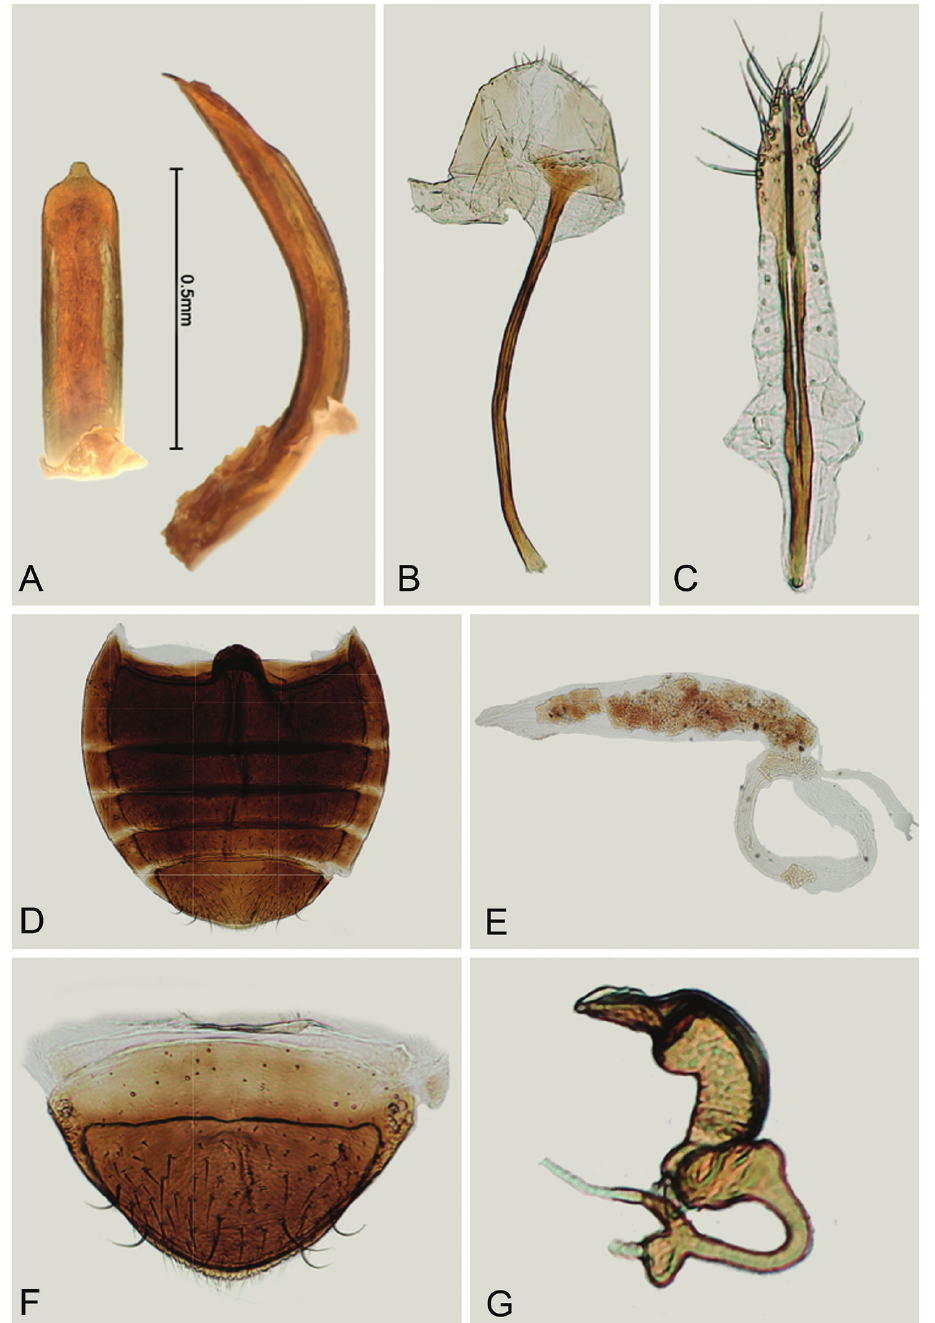
Figure 16. Andersonoplatus lagunanegra . A Median lobe of aedeagus, ventral and lateral views B Tignum C Vaginal palpi D Female abdomen, ventral view E Gut F Last abdominal tergite of female G